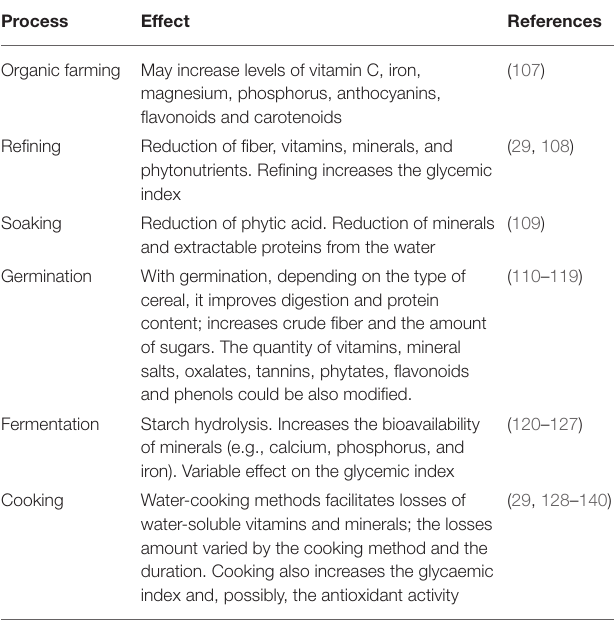
TABLE 3 | Effects of processing on cereals nutrients